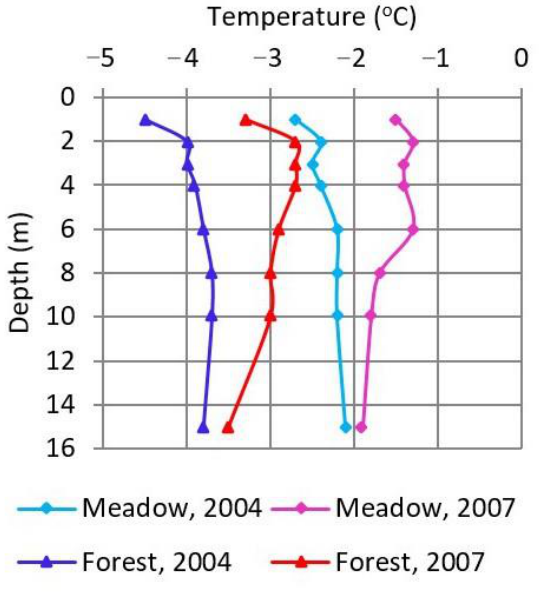
Table 4. Average monthly and mean annual air temperature for certain periods in Yakutsk (°C).